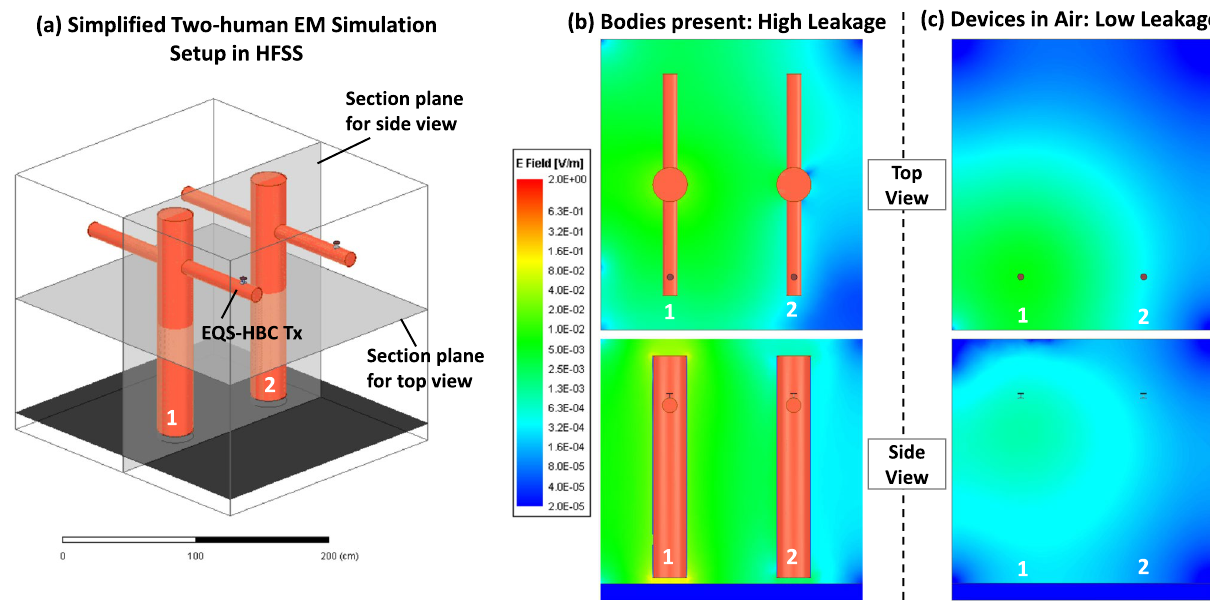
Figure 3. ( a ) Simulation model used in ANSYS HFSS to demonstrate leakage of quasistatic E field through the surface of the human body. The EQS-HBC transmitter on subject 1 is operated at 500 kHz, with a voltage amplitude of 1V. ( b ) Leakage of E field when the bodies are present. High surface area of the body causes a higher leakage between the bodies. ( c ) Leakage of E field in the absence of the bodies. The leaked E field is much more confined and localised around the